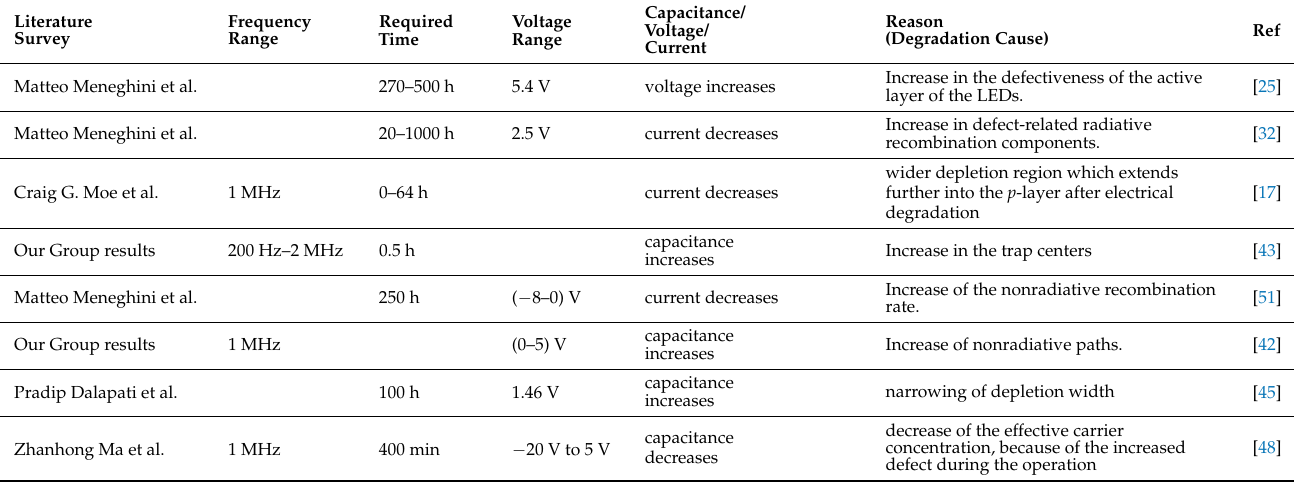
Figure 21. ( a ) The ACD profile of 255 nm LED at different temperatures; ( b ) 1D simulation of ACD profile of 255 nm LED at different temperatures. [56] Copyright 2022, Springer. Table 3. Summary of the C-V response to the stress.